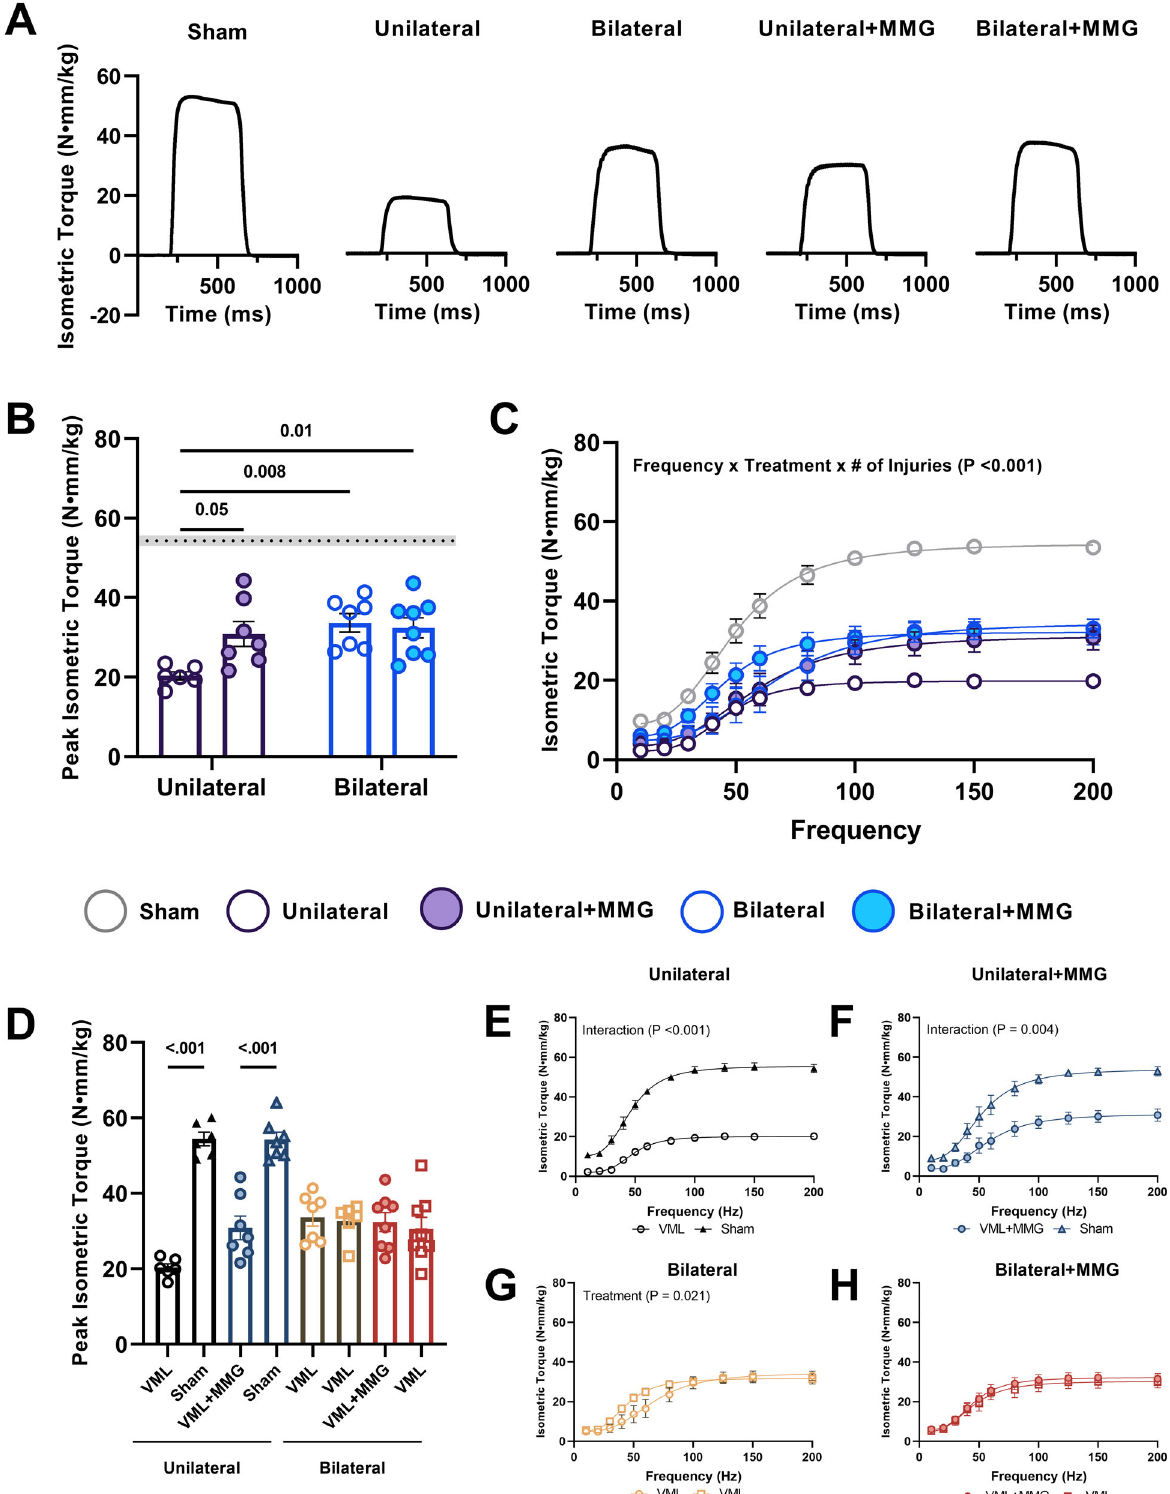
Fig. 2 In vivo neuromuscular function of the TA muscle. Quanti fi cation of in vivo TA muscle neuromuscular strength was assessed at 8-weeks post injury. A Isometric torque tracings at 150 Hz, B peak isometric torque, and C isometric torque as a function of stimulation frequency are presented for the left hindlimb of each group and normalized to body weight. The dashed line and shaded region represent the average peak isometric torque of the contralateral limbs of the unilaterally injured groups. Additionally, peak isometric torque ( D ) and average maximal TA torque as a function of frequency ( E – H ) are presented for the right hindlimb alongside the limb of interest (i.e., left) and broken out by group. Data is presented as mean ± SEM. * = P <